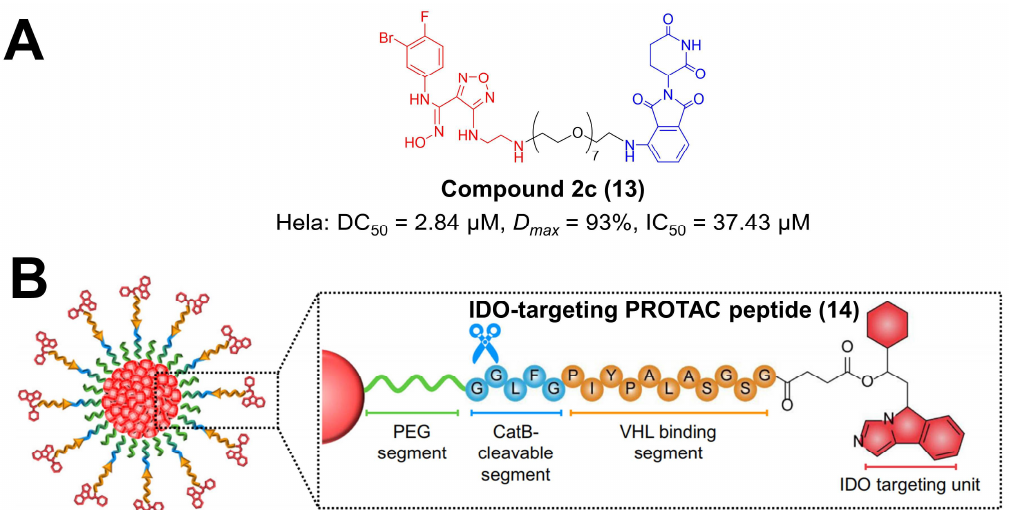
Figure 3. The chemical structures of representative PROTACs targeting IDO1. ( A ) The chemical structure of the first PROTAC targeting IDO1. ( B ) The chemical structure of IDO-targeting PROTAC peptide. DC 50 —half-maximal degradation concentration; Dmax —maximum degradation; IC 50 —half-maximal inhibition concentration.